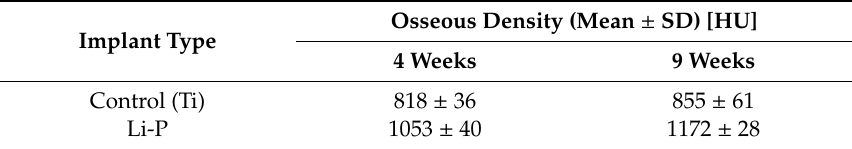
Table 2. Osseous density (mean ± SD) inferred at the implant–bone interface for control and functionalized (with Li-P coatings) 3D Ti implants.